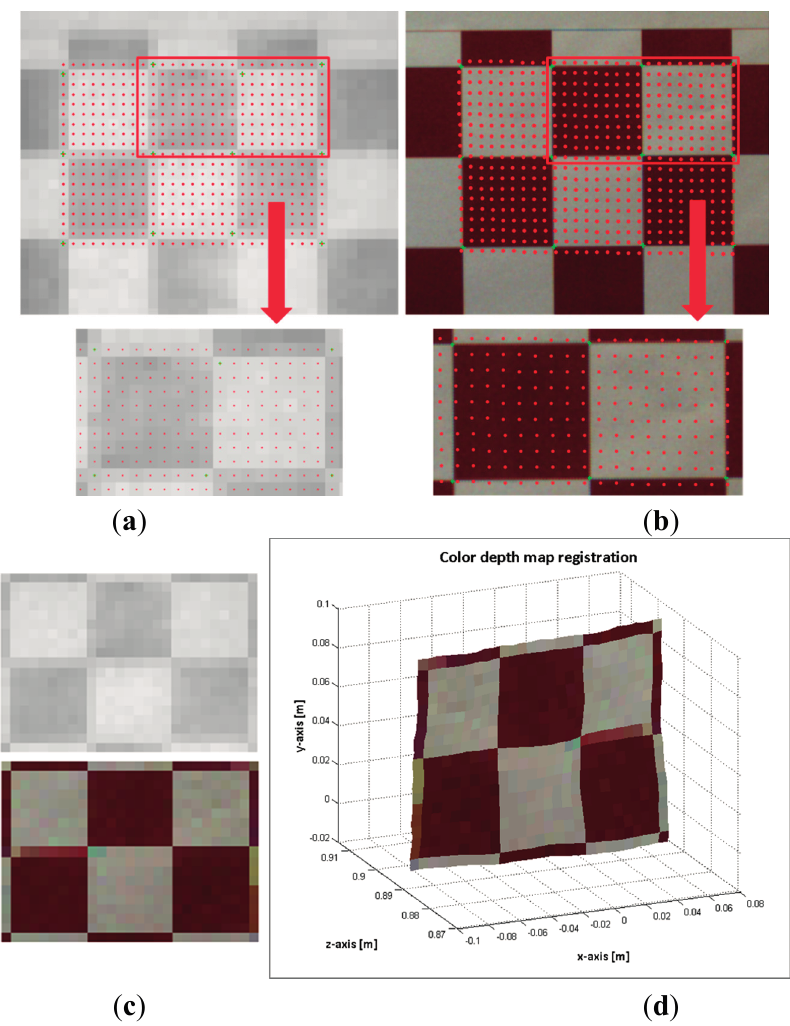
Figure 9. Image sample 25-pattern board positioned at 527 mm. ( a ) Top: selected ROI on the ToF image. Bottom: zoom of the selected points on the ToF image; ( b ) Top: mapped points on the RGB image. Bottom: zoom of the estimated points on the RGB image; ( c ) Top: ROI of the ToF image. Bottom: Composition ROI from the mapped points on the RGB image; ( d ) colour depth